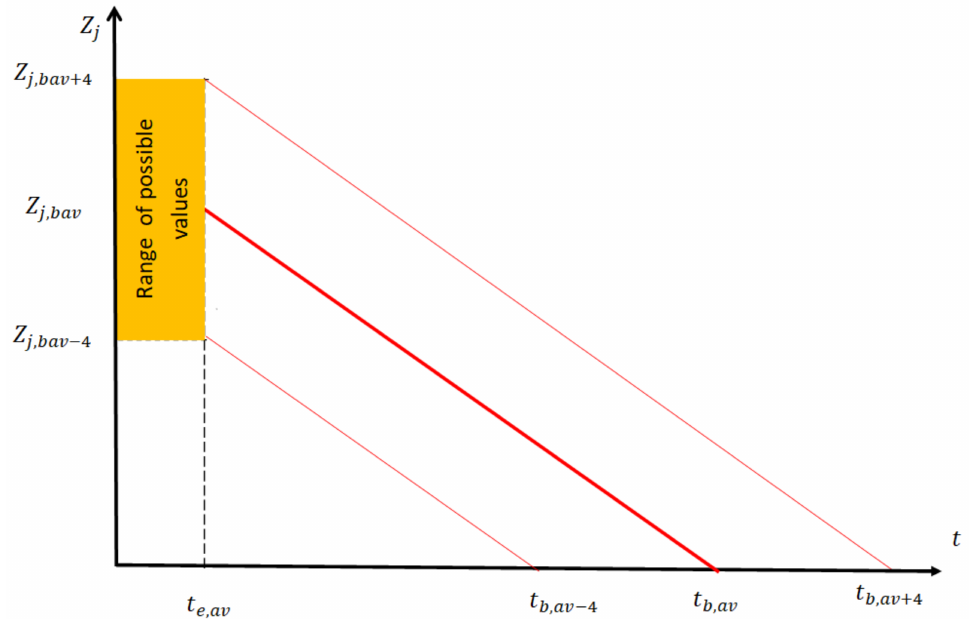
Figure 5. The range of standardized individual indications of HCAs depending on the fluctuations of the base temperature in the range of ± 4 ◦